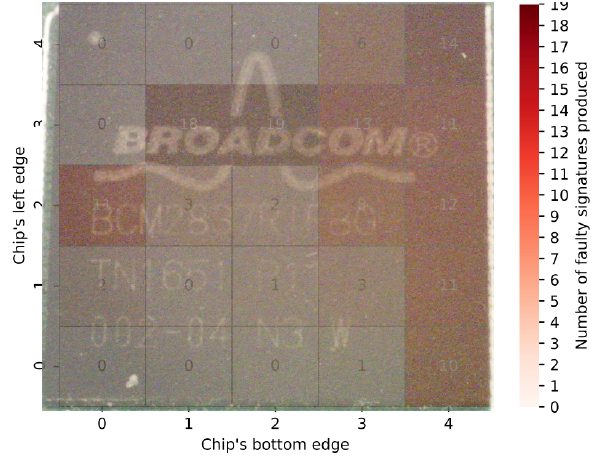
Figure 6. Cartography results overlaid with a photograph of the